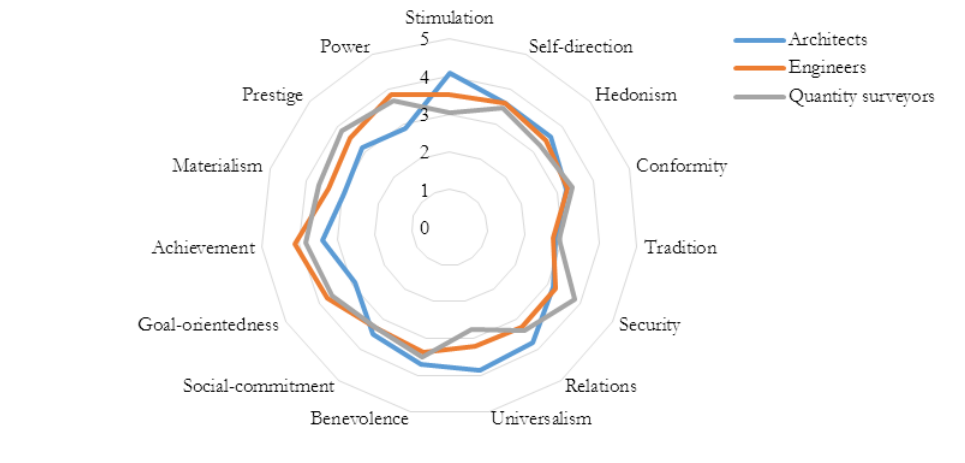
Figure 2: Comparing the professions based on the 15 value